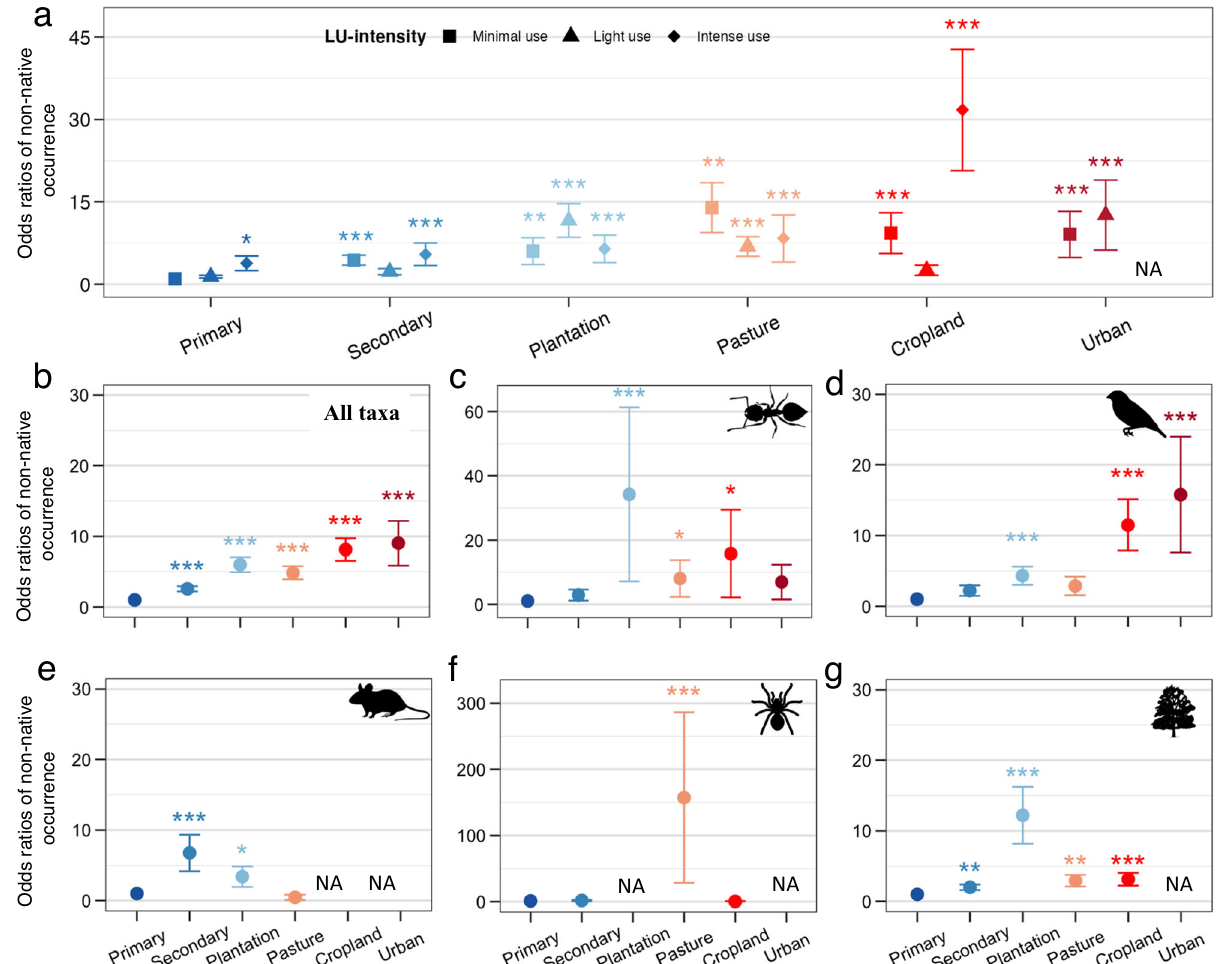
Fig. 2 | Odds ratios of non-native species occurrence in local assemblages in responsetoLU-typeandLU-intensity.a alogisticgeneralisedlinearmixedeffects model with LU-type, LU-intensity and their interaction as predictors ( n =11,693); b – g theeffectofLU-typemodelledacrossalltaxa( b )( n =11,713)andforeachtaxon separately ( c – g ) ( n =407, 3978, 1114, 762 and 4453; respectively). All p -values are based on two-sided tests. Odds ratios from contrasts to the reference levels ( ‘ Pri- mary under Minimal use ’ ( a ) or ‘ Primary vegetation ’ ( b – g )) are back-transformed fromthelogarithmicscaleofthemodels,respectively.Shownaremeanoddsratios (dots)andstandarderrors(bars).Asterisksindicatesigni fi cantdifferencesfromthe